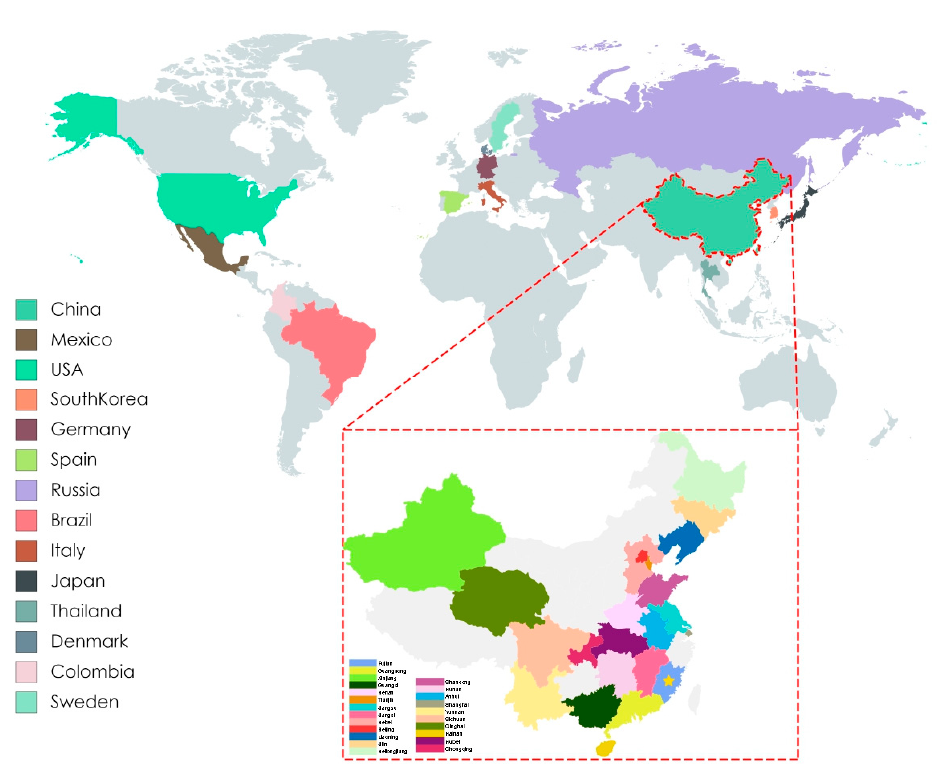
Figure 1. Map of PCV3 positive farms by country, and by province in China. Colored rectangles correspond to indicated PCV3 positive country and Chinese provinces. The yellow star indicates Fujian